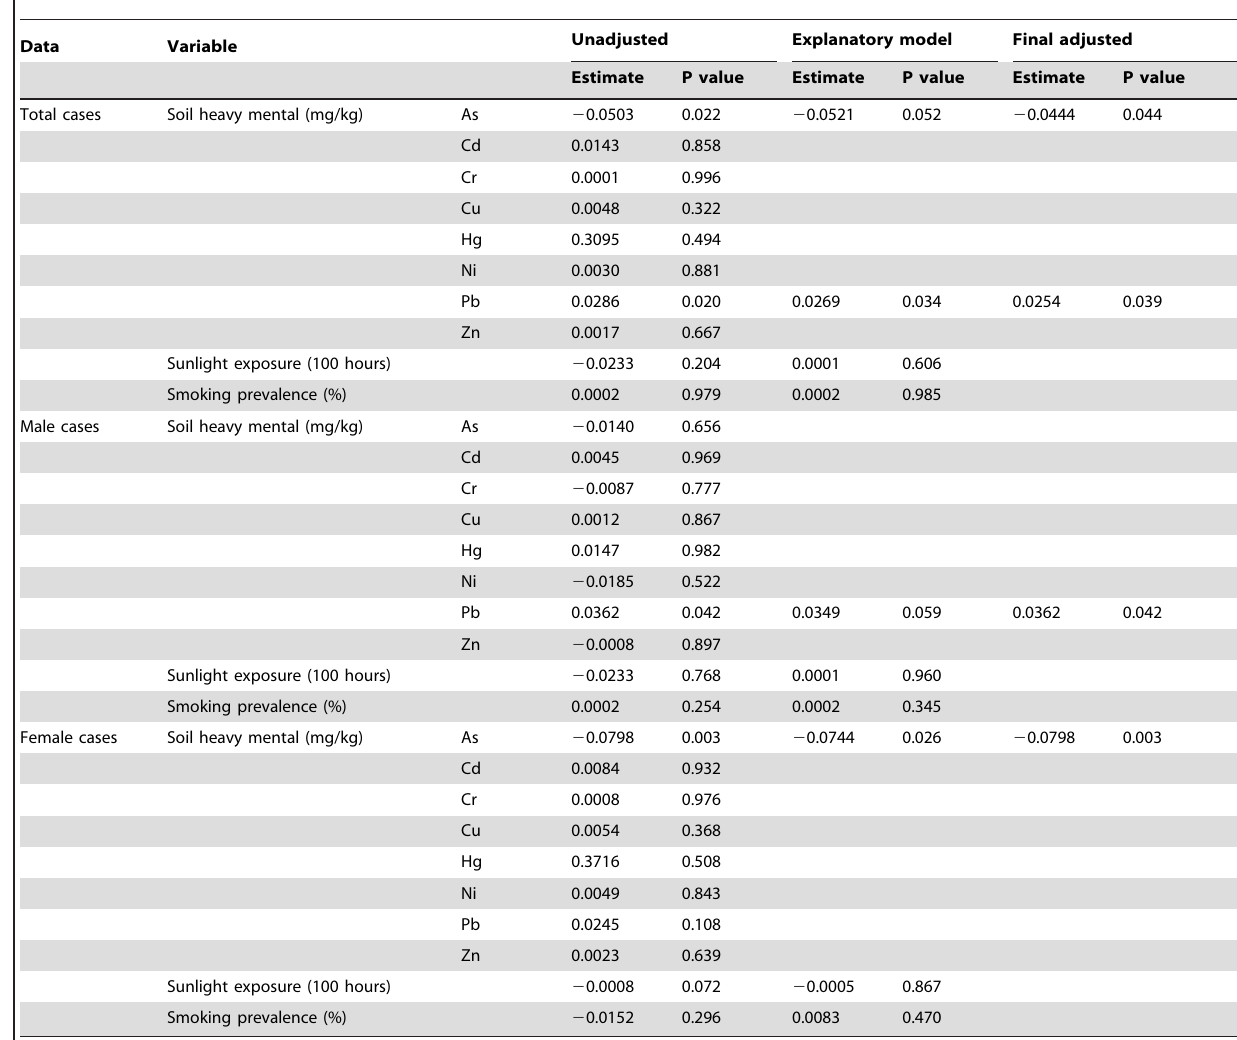
Table 3. Spatial regression analysis on age-standardized incidence ratios of MS in Taiwan,